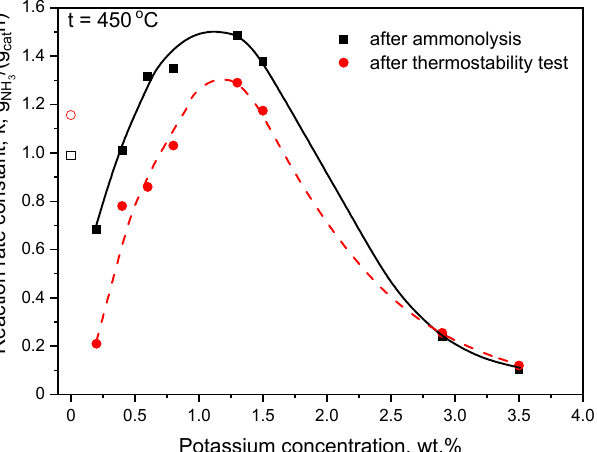
Figure 4. Catalytic activity of COMON catalysts as a function of the potassium concentration measured after ammonolysis and after the thermostability test. Catalytic tests were carried out at 450 °C under 10 MPa. Lines are given for eye guidance.